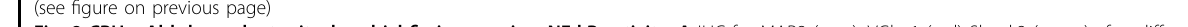
Fig. 8 CRH-c-Abl dependent mitochondrial fi ssion requires NF-kB activity. A IHC for MAP2 (gray), VGlut1 (red) Shank2 (green) after different treatments (scale bar = 5 μ m). White arrowheads indicate the co-localization between VGlut1 and Shank2. Quanti fi cation of excitatory synapses number (co-localization of Shank2/Vglut1/30 μ m of dendrites). Three different dendrites of three different neurons acquired from three different wells were analyzed for each condition in each independent experiment. B WB analysis of DRP1 S616 expression, blocking the NF- κ B pathway with the nuclear translocation blocker JSH-23. C IHC for MAP2 (gray) and c-Abl T754 (red) in primary neurons after different experimental conditions using JSH- 23 (scale bar = 30 μ m): vehicle, vehicle + JSH 10 μ M, CRH 100 nM for 0.5 h, CRH 100 nM + JSH 10 μ M with relative c-Abl T754 intensity analysis. Nine different neurons acquired from three different wells were analyzed for each condition in each independent experiment. Representative western blot and relative quanti fi cation of: D S-nitrosylation levels of DRP1 and E of iNOS expression following CRH treatment; F iNOS expression levels in 5 Txt mice. Experiments were performed in N = 3 independent replicates at DIV14. Data are displayed as Mean ± SEM; one-way ANOVA and Bonferroni ’ s post hoc comparison test were performed ( *p < 0.05, **p < 0.005, ***p < 0.0005, ****p <